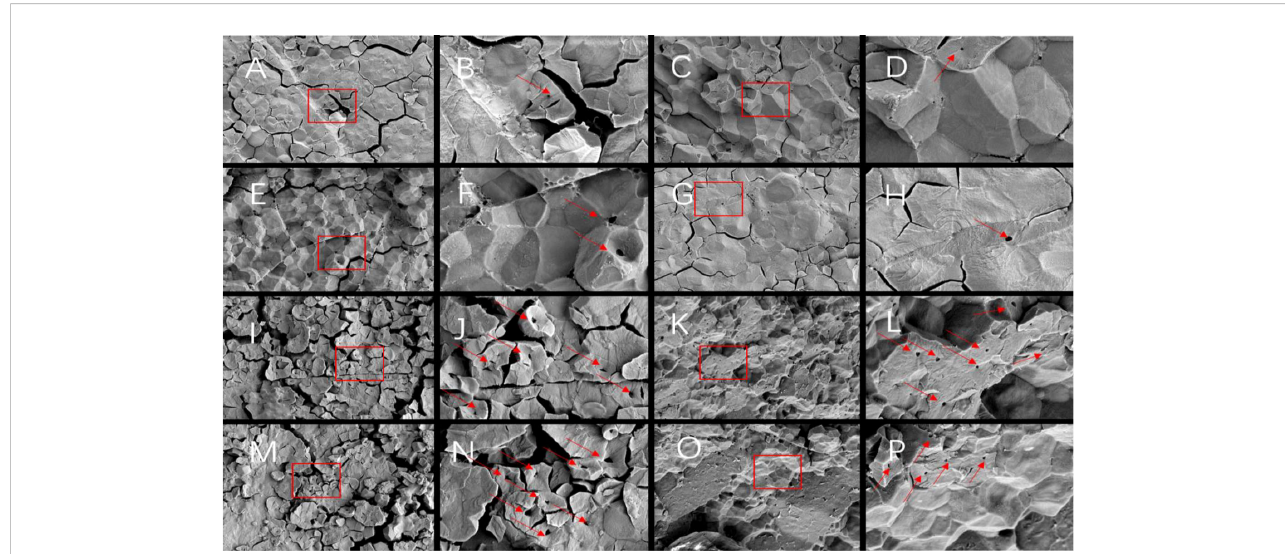
FIGURE 5 Endosperm belly of (A, B) normal grains and (C, D) non-chalky grains of Y28, (E, F) normal grains and (G, H) non-chalky grains of N5718, (I, J) normal grains and (K, L) non-chalky grains of W113, (M, N) normal grains and (O, P) non-chalky grains of Y5118. A/C/E/G/I/K/M/O are at 1500x and B/D/F/H/J/ L/N/P are at 5000x. B/D/F/H/J/L/N/P are the enlarged view of red rectangle areas in A/C/E/G/I/K/M/O ,